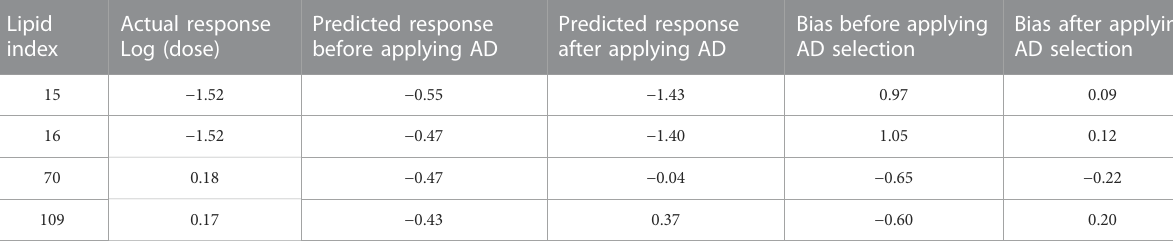
TABLE 6 Re fi nement of predictions by selecting training lipids within